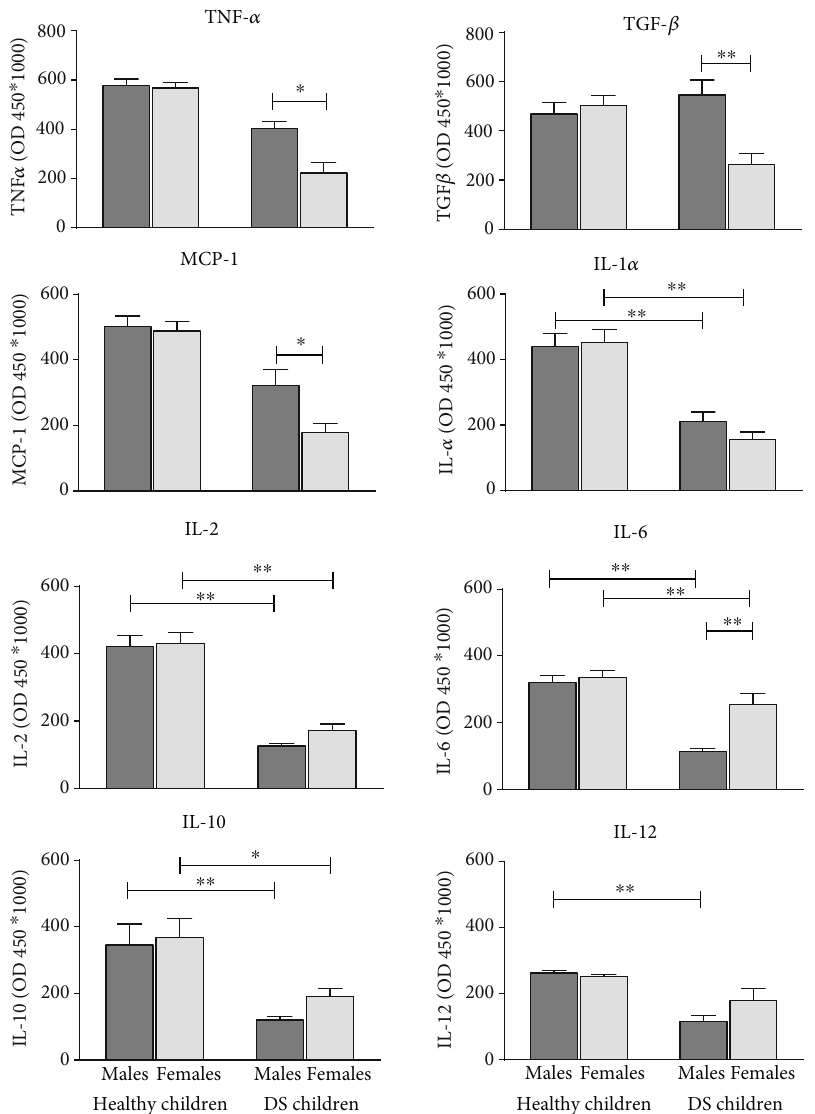
Figure 4: TNF- α , TGF- β , MCP-1, IL-1 α , IL-2, IL-6, IL-10, and IL-12 serum levels in male and female DS prepubertal children and in the control group. The error bars indicate pooled standard error means (SEM) derived from appropriate error mean square in the ANOVA. The asterisks indicate signi fi cant di ff erences between groups ( ∗ p < 0 : 05 ); ( ∗∗ p < 0 : 01